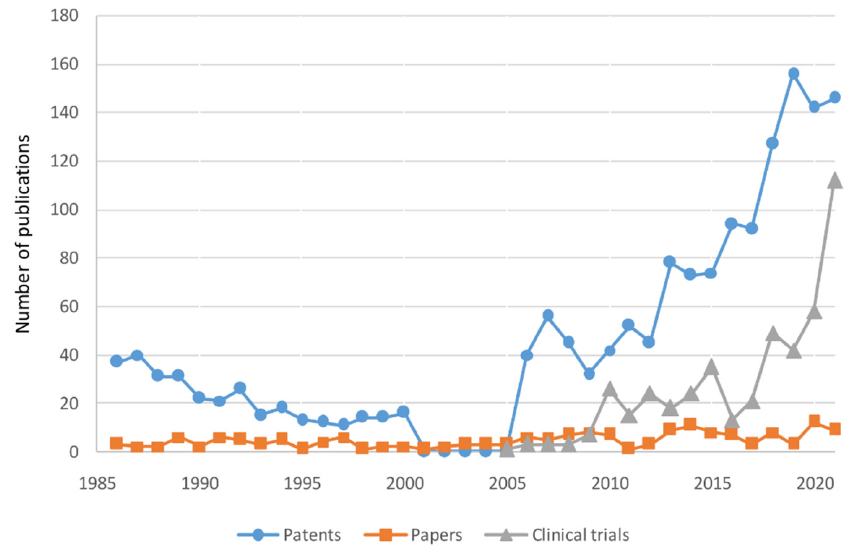
Figure 5. Number of patents, papers, and clinical trials for IOLs by year.